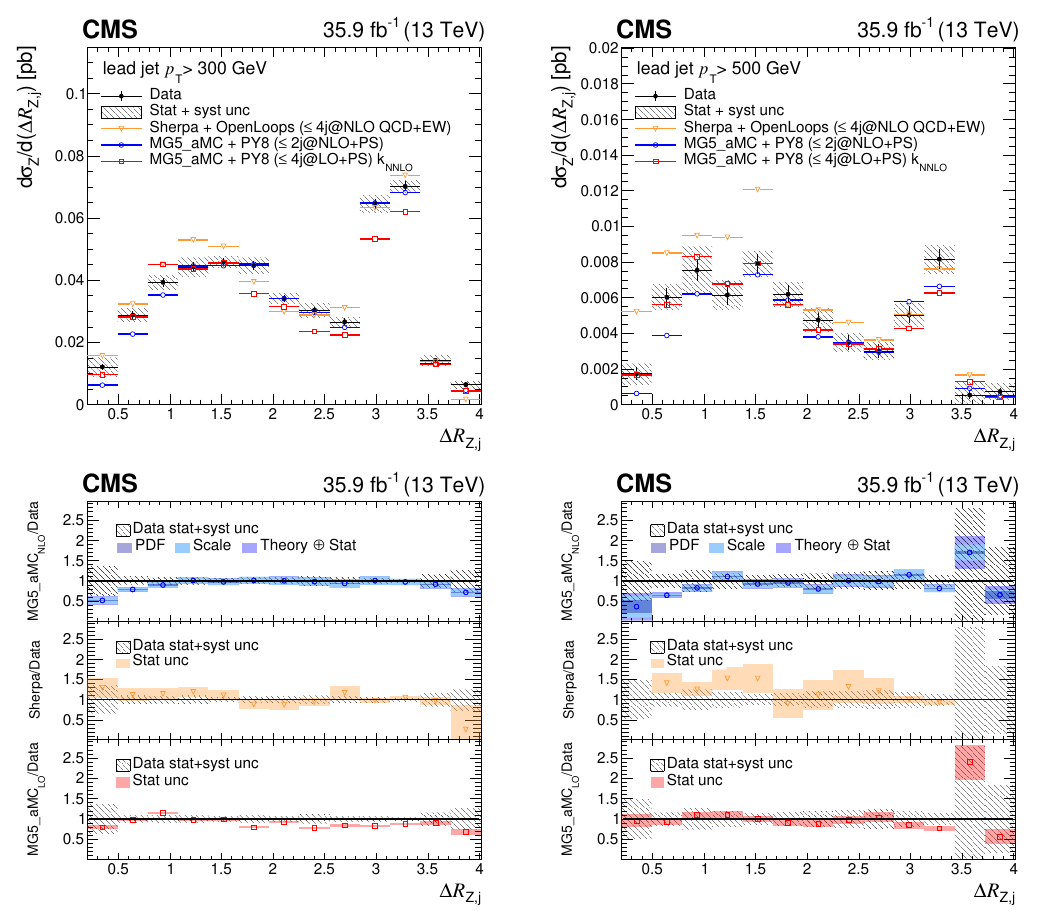
Figure 4 . Measured differential cross section of Z + jets as a function of the angular separa- tion between the Z boson and the closest jet, compared with theoretical predictions from Mad- Graph 5_a mc@nlo and sherpa + OpenLoops , where the leading jet p is above 300 (left) and T 500 (right) GeV. The vertical bars in the upper panel represent the statistical uncertainty in the measurement and the hatched band in the lower and upper panels is the sum in quadrature of the statistical and systematic uncertainty components in the measurement. The lower panels show the ratio of the theoretical predictions to the unfolded data. The shaded band on the LO Mad- Graph 5_a mc@nlo and sherpa + OpenLoops calculations is the statistical uncertainty. The dark (light) shaded band on the NLO prediction from MadGraph 5_a mc@nlo represents the PDF (scale)